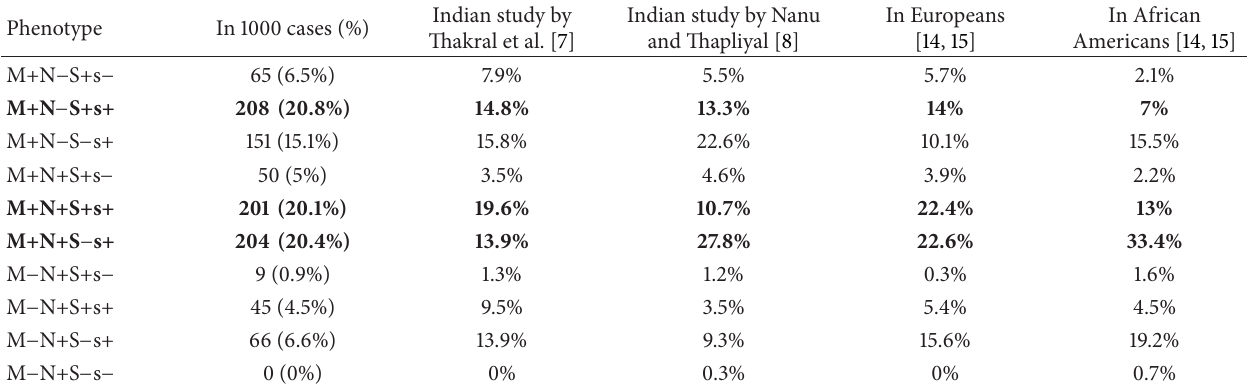
Table 6: Combined phenotype frequencies of MNSs in MNS blood group